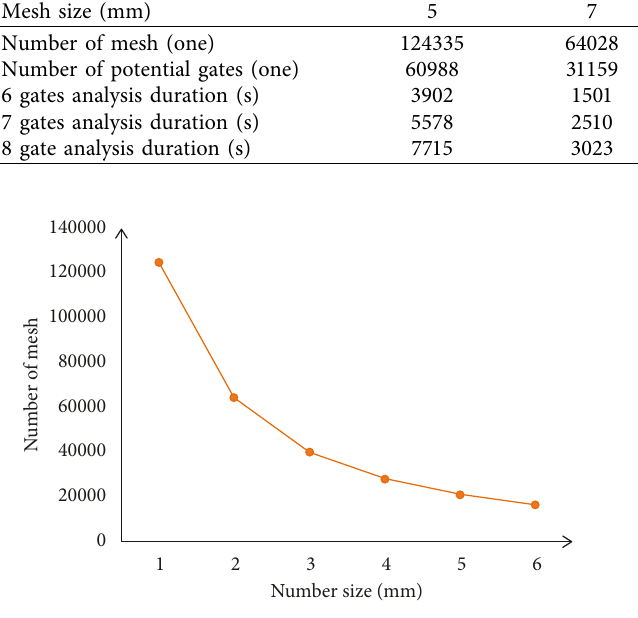
Figure 5: Mesh size and number of mesh diagrams.